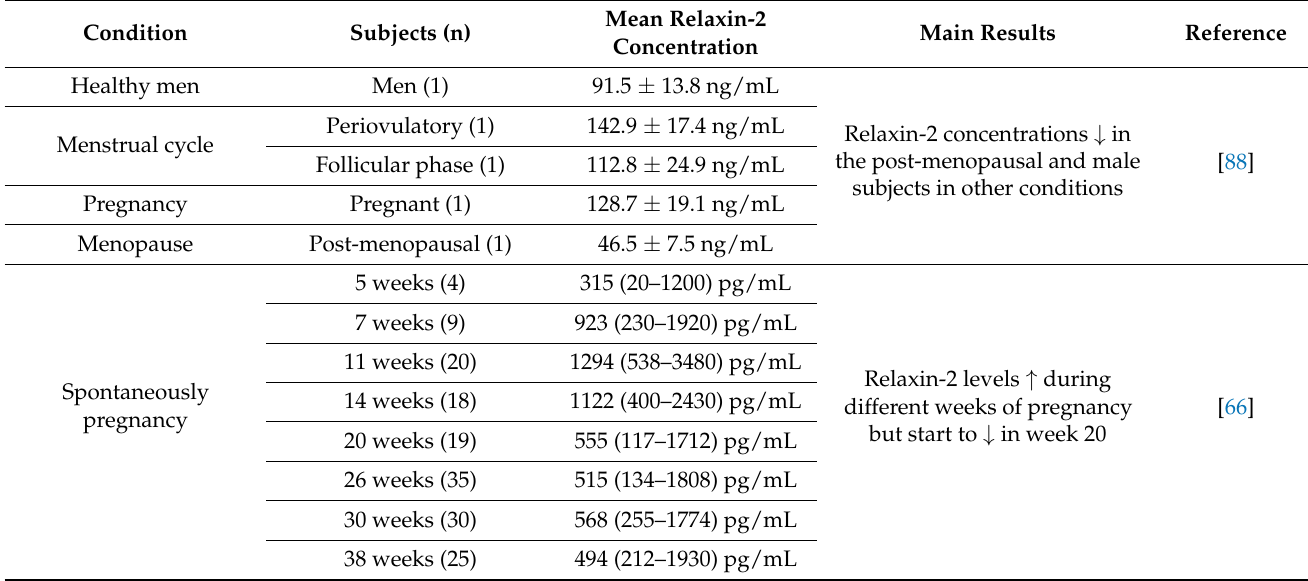
Table 1. Relaxin-2 plasma or serum levels in different physiological